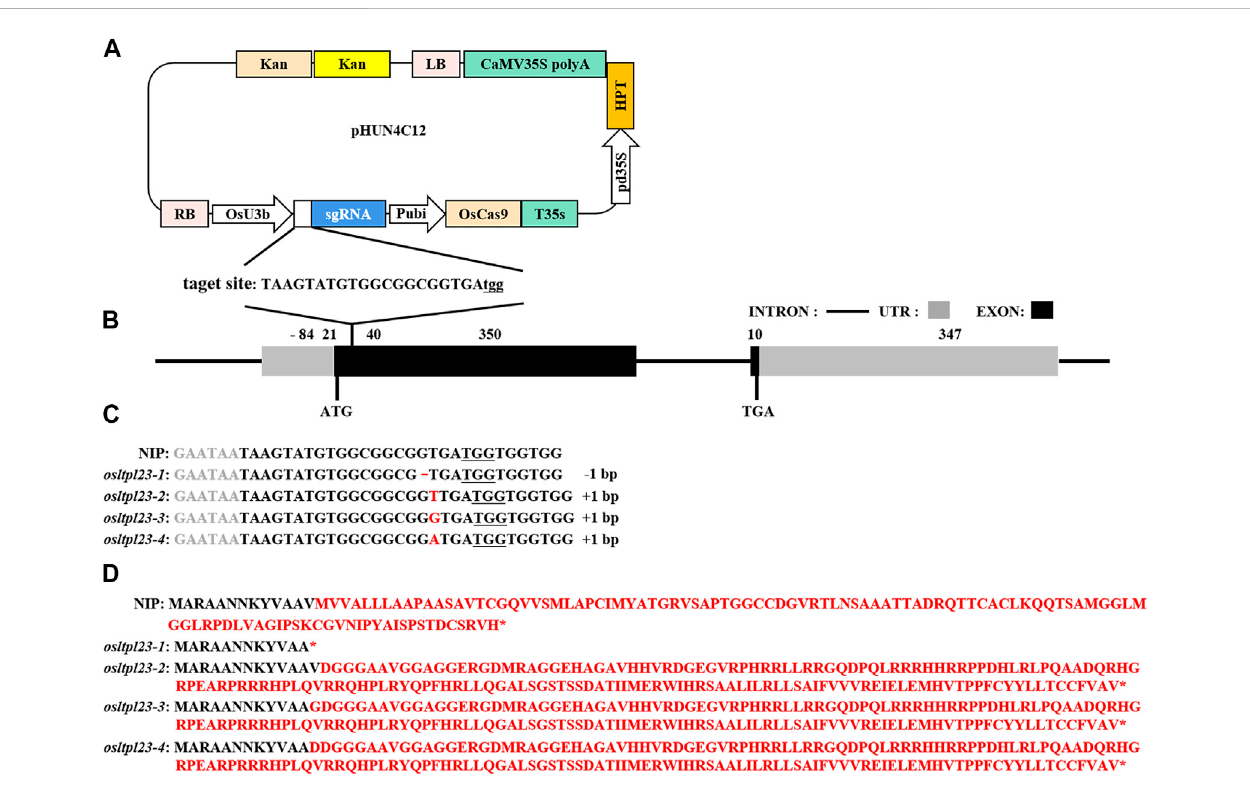
FIGURE 4 Cas9-mediated OsLTPL23 gene mutation in rice. (A) Target site sequence and CRISPR/Cas9 vector structure. Capital letters indicates the sgRNA sequences, and three underlined lowercase letters represent the protospacer adjacent motif (PAM). The expression of Cas9 , sgRNA and hygromycin ( HPT ) is separately driven by the maize ubiquitin promoter (Pubi), rice U3b promoter (OsU3b) and 35S promoters (pd35S). (B) Schematic of the OsLTPL23 gene structure.Blackrectangles,grayrectanglesandblacklinesrepresentexon,untranslatedregion(UTR)andintron,respectively. (C) Thegeneeditingevents in the four rice homozygous mutants. The underlined nucleotide sequences are PAM. The red lines and capital letters represent deleted nucleotide and inserted nucleotide, respectively. (D) Predicted protein sequences encoded by mutational OsLTPL23 in osltpl23